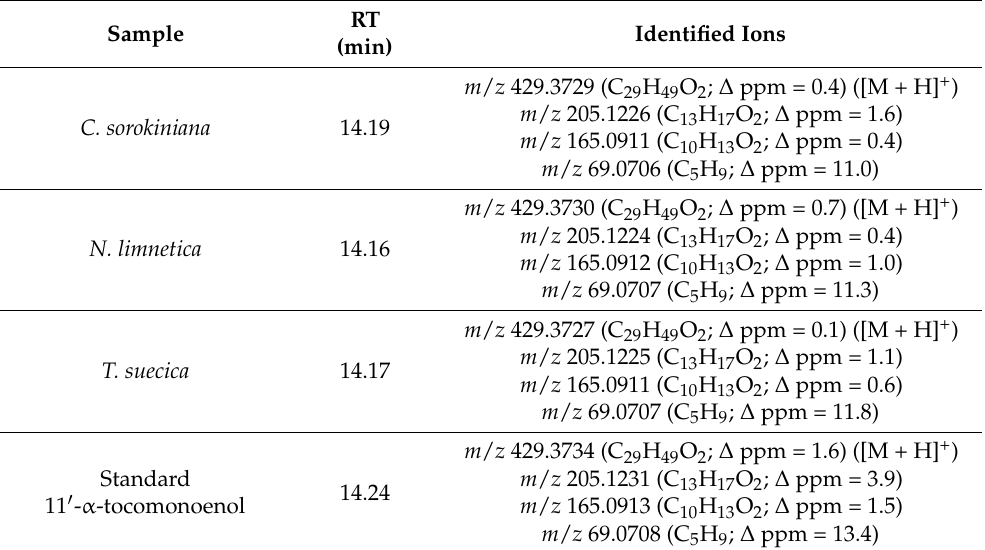
Table 1. Fragmentation patterns for targeted analysis of α -tocomonoenols ( α T1) in Chlorella sorokini- ana , Nannochloropsis limnetica , and Tetraselmis suecica using LC-MS n . Sample